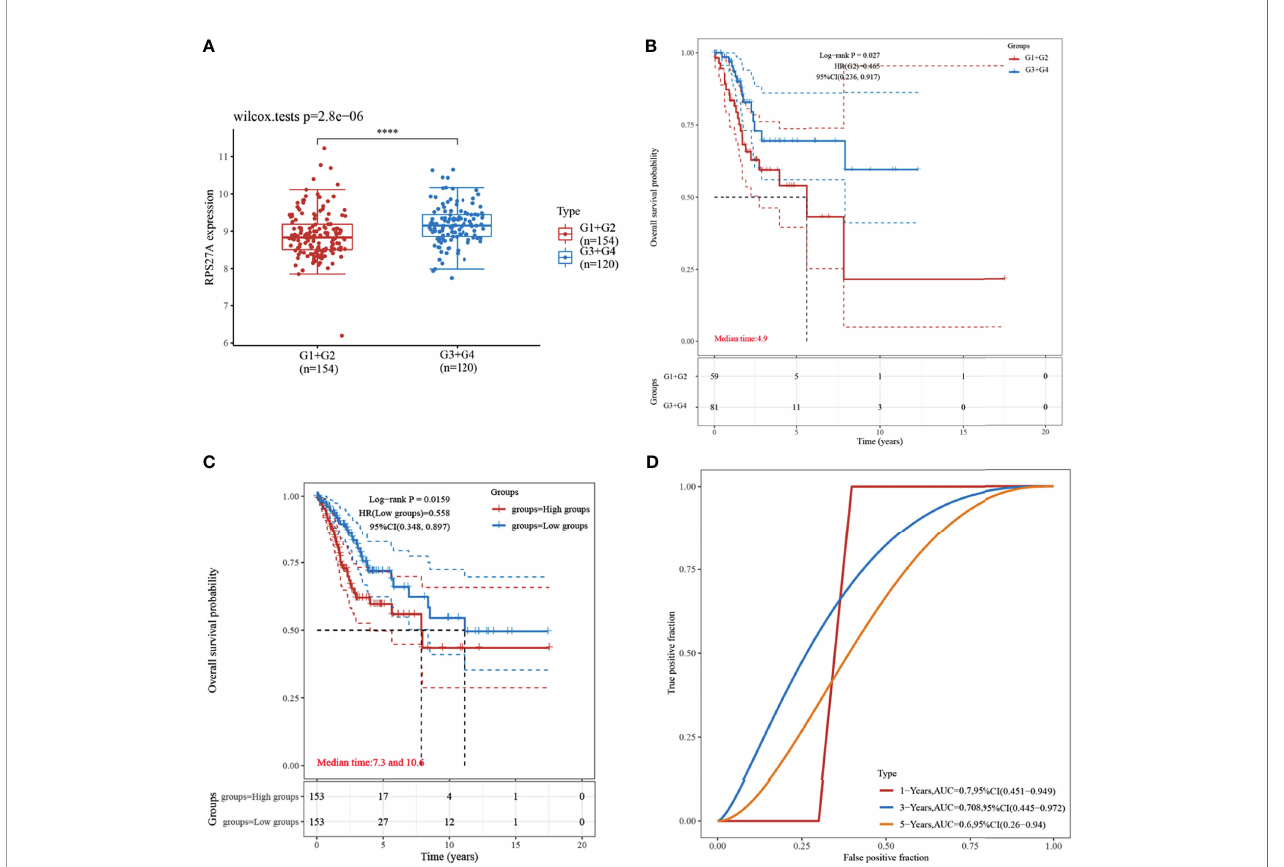
FIGURE 5 | Clinical expression comparison and prognostic analysis of RPS27A . (A) Comparison of the expressions in different clinical stages, ****P < 0.0001. (B) Prognostic impact of a high RPS27A expression in clinical analysis. (C) Kaplan – Meier curve distribution of high and low RPS27A expressions. (D) Receiver operating characteristic (ROC) curve of the different survival times of RPS27A